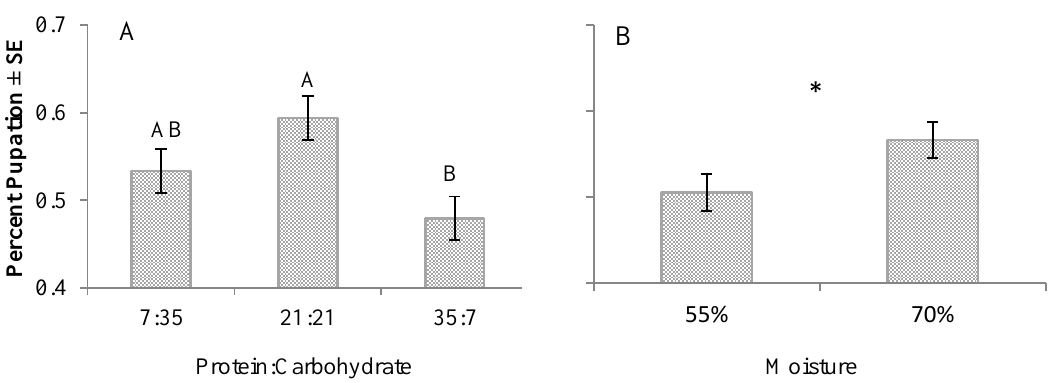
Figure 3. ( A ) Effects of diet protein:carbohydrate on percent pupation. (B) Effects of diet moisture on percent pupation. Letters (ANOVA followed by Tukey–Kramer HSD) or asterisk ( t -test) indicate significant differences (α = 0.05) for each corresponding diet parameter.